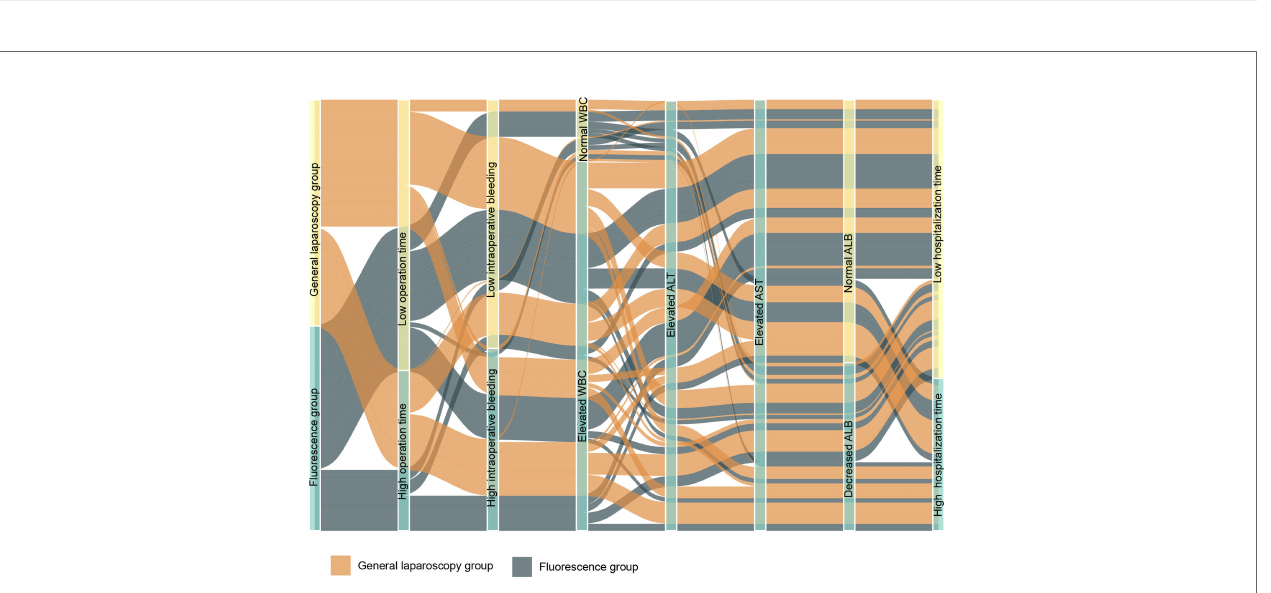
FIGURE 9 | Sankey diagram showing the statistical differences between the two